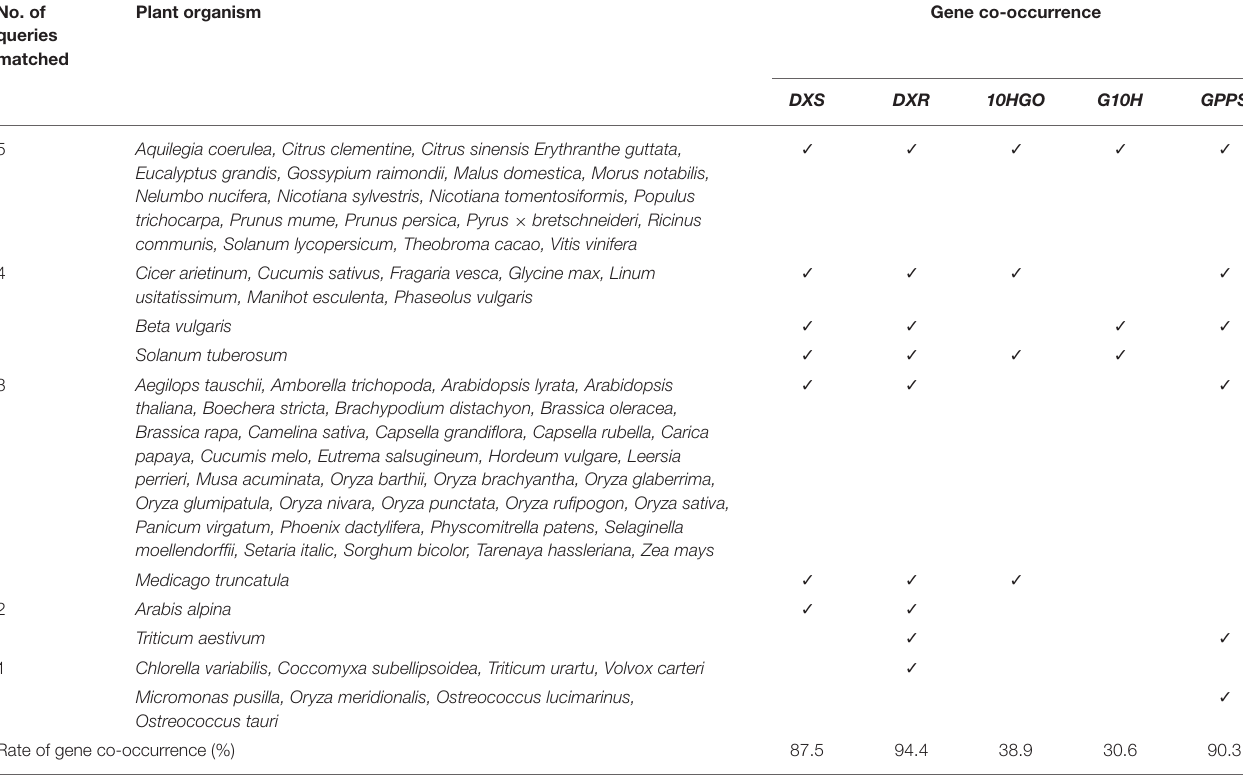
TABLE 1 | Co-occurrence on DXS, DXR, GPPS, G10H, or 10HGO family. No. of Plant organism Gene queries matched